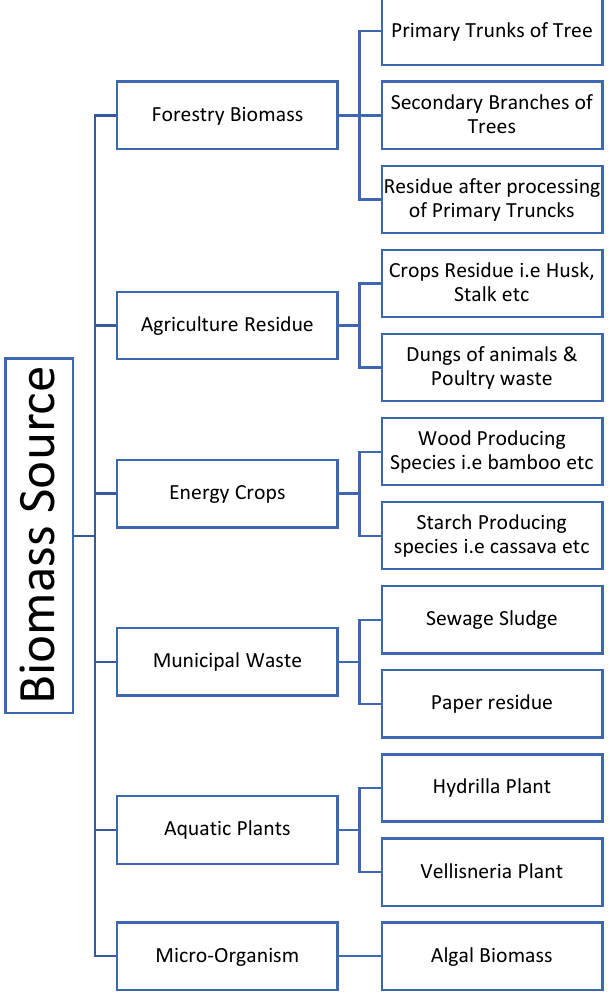
Figure 2. Different biomass for HTL.